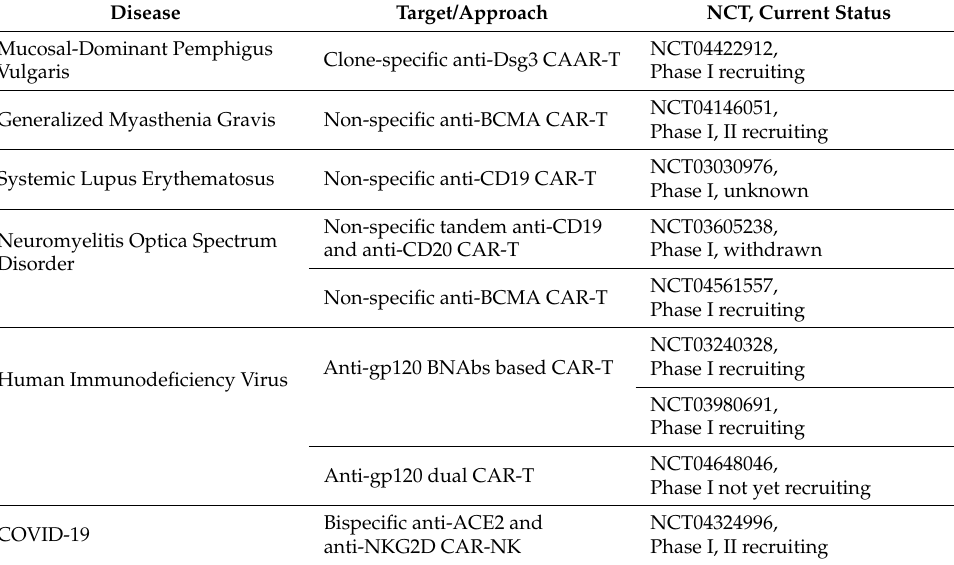
Table 1. The list of clinical trials of chimeric antigen receptor (CAR)-T cell therapy beyond oncology.